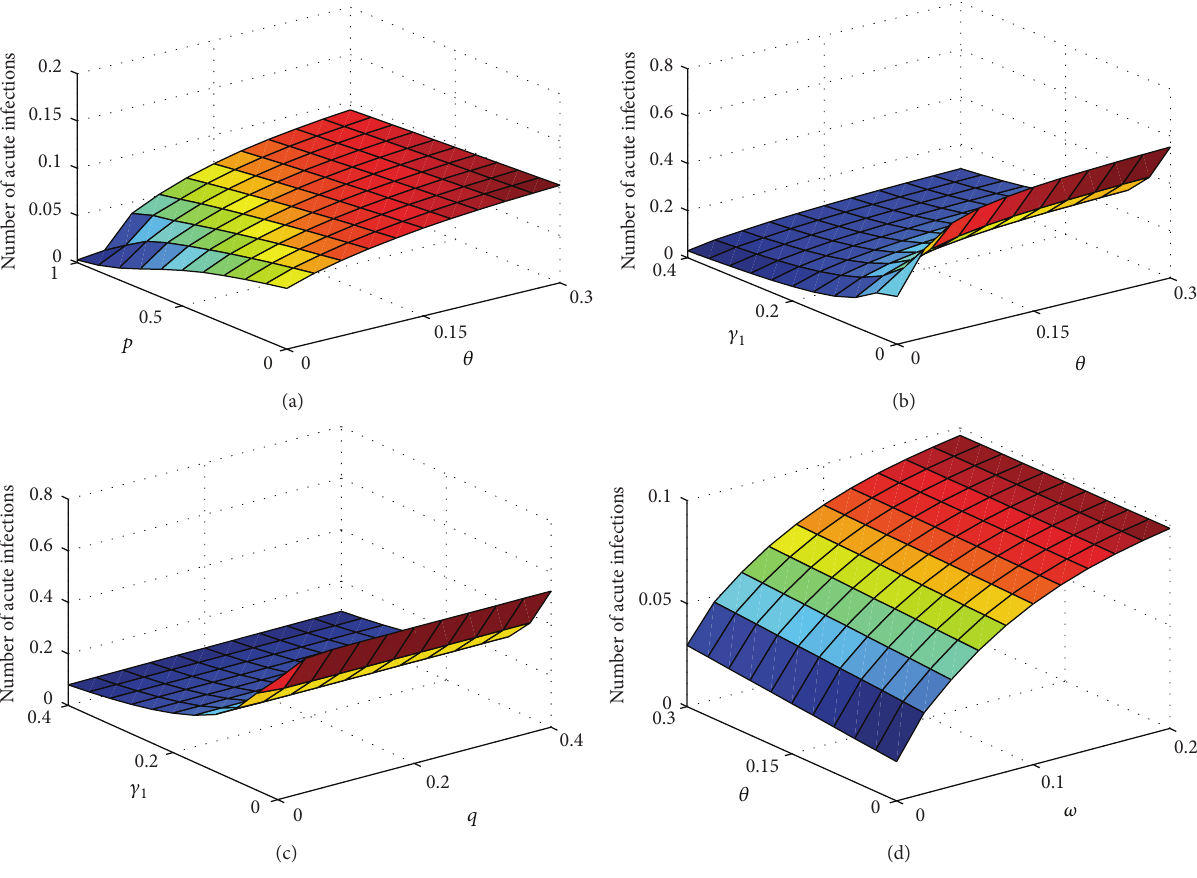
Figure 3: The graphs of the number of acute infectors with some parameters: (a) 𝜇 = 0.1 ; 𝜐 = 0.1 ; 𝜑 = 0.1 ; 𝛽 = 12 ; 𝜀 = 0.16 ; 𝛾 2 = 0.025 ; = 0.028 ; 𝜏 = 5 ; 𝛾 = 0.4 ; 𝑞 = 0.4 ; 𝜔 = 0.2 , surf 𝑝 ∈ [0, 1],𝜃 ∈ [0,0.3] . (b) 𝜇 = 0.1 ; 𝜐 = 0.1 ; 𝜑 = 0.1 ; 𝛽 = 12 ; 𝜀 = 0.16 ; 𝛾 𝜇 1 1 ∈ [0,0.4] . (c) 𝜇 = 0.1 ; 𝜐 = 0.1 ; 𝜑 = 0.1 ; 𝛽 = 12 ; 𝜀 = 0.16 ; 𝛾 𝜏 = 5 ; 𝜔 = 0.2 ; 𝑞 = 0.4 ; 𝑝 = 0.6 , surf 𝜃 ∈ [0,0.3], 𝛾 1 ∈ [0,0.4], 𝑞 ∈ [0,0.4] . (d) 𝜇 = 0.1 ; 𝜐 = 0.1 ; 𝜑 = 0.1 ; 𝛽 = 12 ; 𝜀 = 0.16 ; 𝛾 𝜔 = 0.2 ; 𝜃 = 0.2 ; 𝑝 = 0.8 , surf 𝛾 1 𝑞 = 0.4 ; 𝑝 = 0.6 , surf 𝜃 ∈ [0,0.3], 𝜔 ∈ [0,0.2]